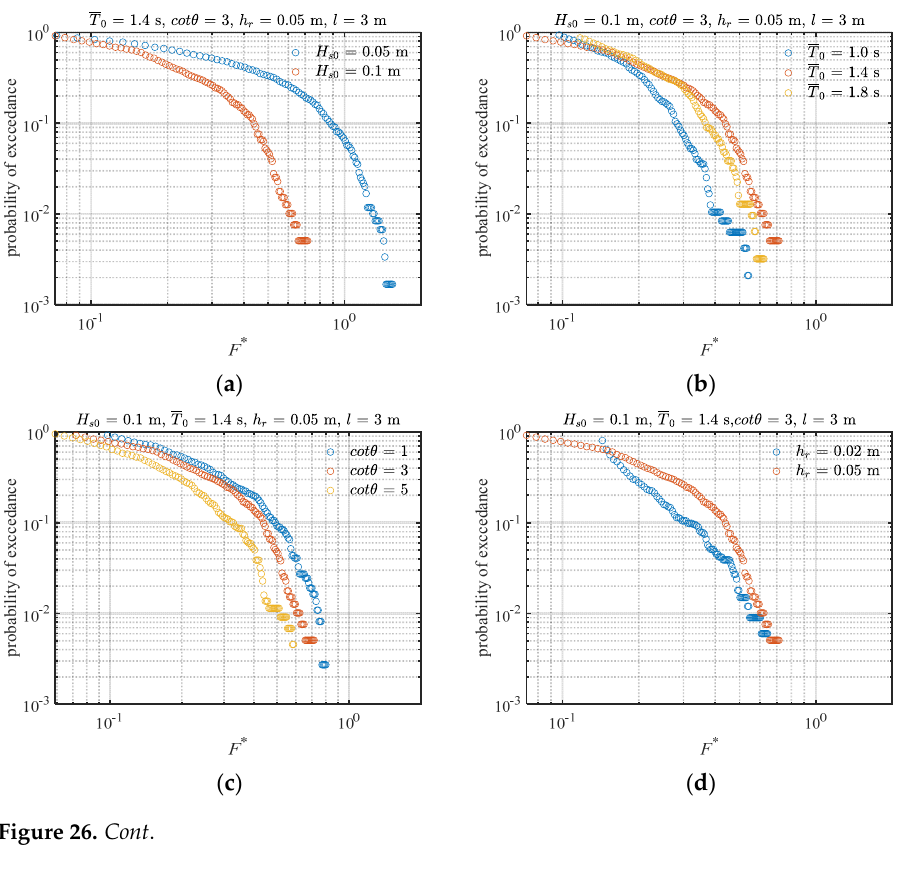
( e ) Figure 26. Probability of exceedance of irregular wave force on the vertical seawall for di ff erent cases: ( a ) H s 0 ; ( b ) 0 T ; ( c ) cot θ ; ( d ) h r ; ( e ) l .